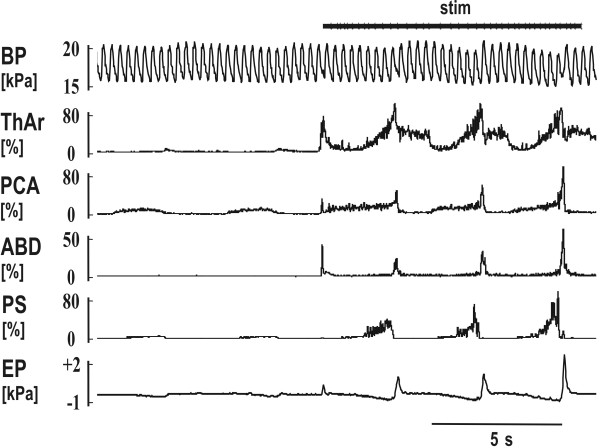
The reflex responses to the mechanical stimulation (stim) in the trachea. Two quiet breaths (slight inspiratory increase in the records of laryngeal abductor posterior cricoarytenoid – PCA and parasternal muscles – PS EMG moving averages with a depression in esophageal pressure – EP) followed by a short reflex expiration (ERt) at the beginning of stimulation (steep elevations in EMG moving averages of laryngeal adductor thyroarytenoid muscle – ThAr, PCA, and abdominal muscles – ABD, as well as in EP). The ERt was then followed by 3 coughs in which the expulsions caused slight elevations of blood pressure (BP). Moderate post-inspiratory activity was present at the inspiratory-expiratory transition of quiet breathing in ThAr. The ERt was markedly shorter compared to the cough expulsions (see ABD and EP) leading to the lower amplitude of EP compared to that in coughs, although the amplitudes of ABD EMG moving averages remained comparable.